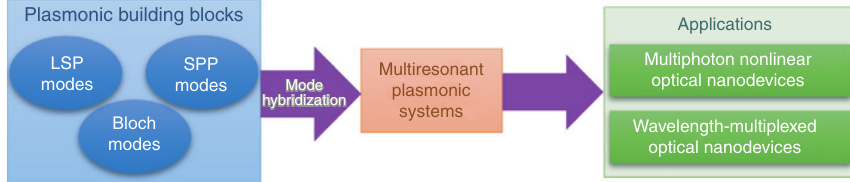
Figure 1: A block-diagram illustration of the strategy to create multiresonant plasmonic systems by plasmonic mode hybridization and the potential applications enabled by multiresonant plasmonics with spatial mode